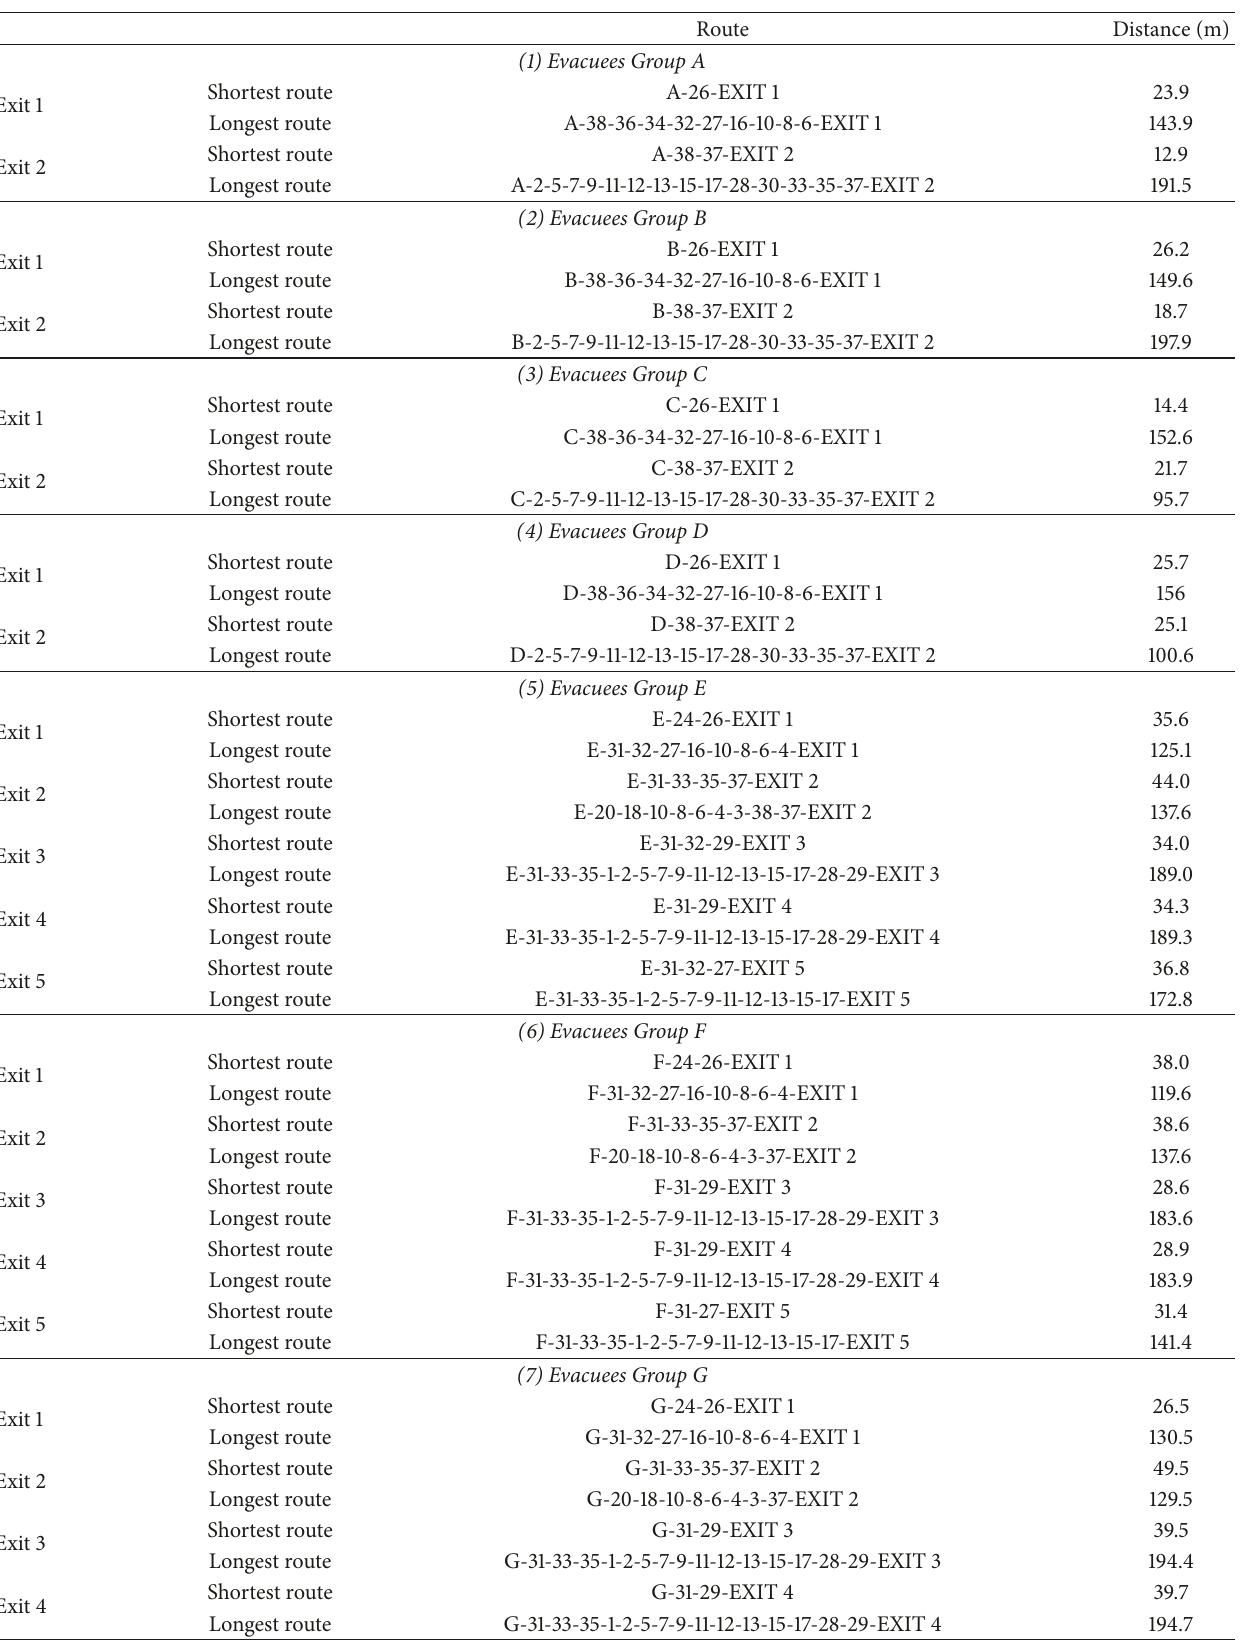
Table 3: Possible routing solutions in VISSUM.